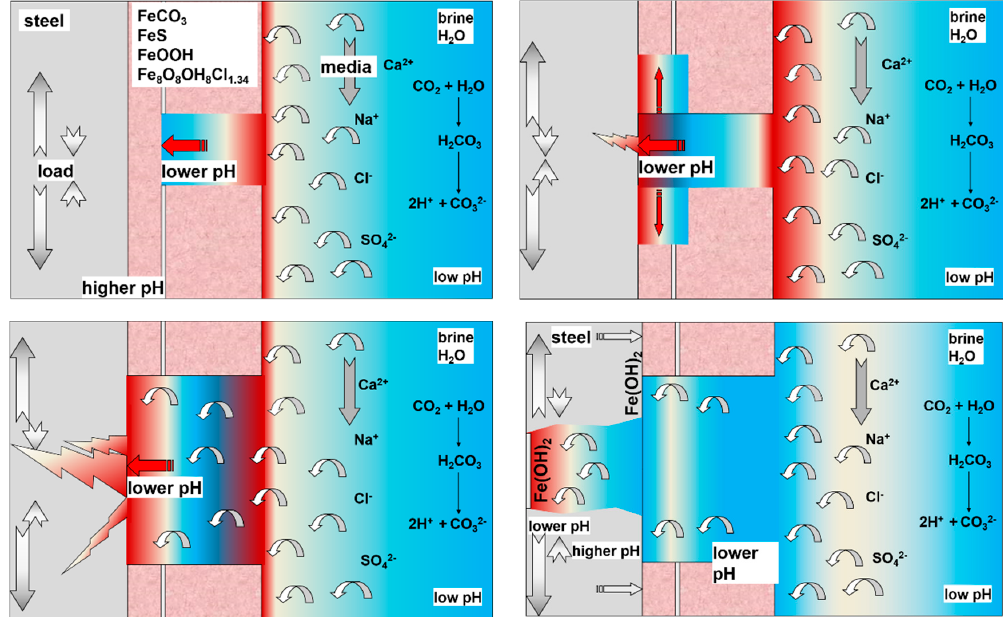
Figure 18. Schematic crack initiation model modified by Han et al. [37].